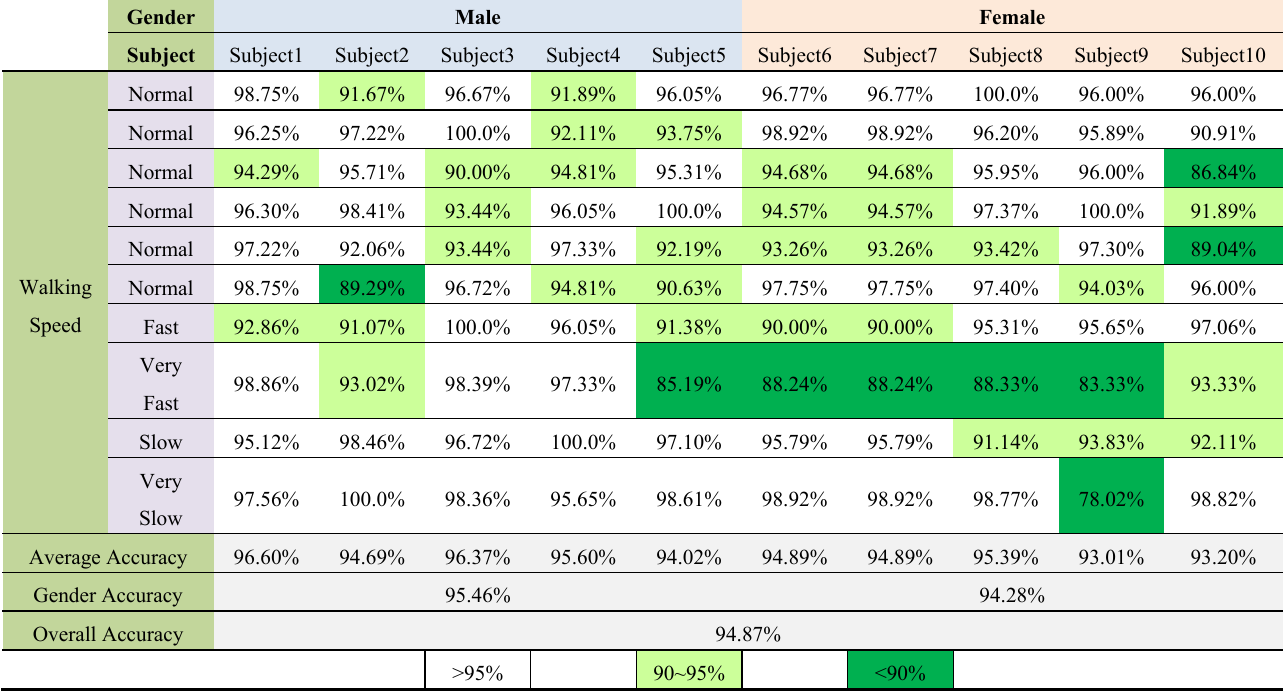
Table 2. Step detection accuracy.